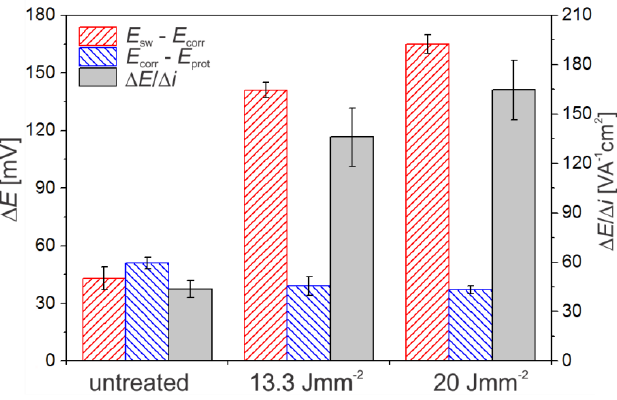
Figure 10. Comparison of ΔE trend as a function of samples in 0.5 M NaCl solution.